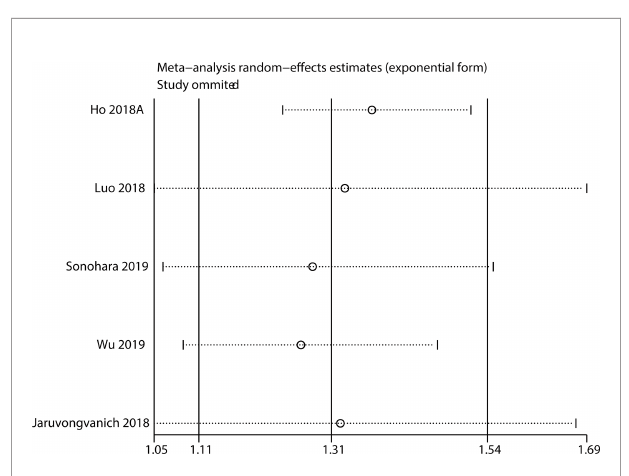
FIGURE 6 | Sensitivity analysis for